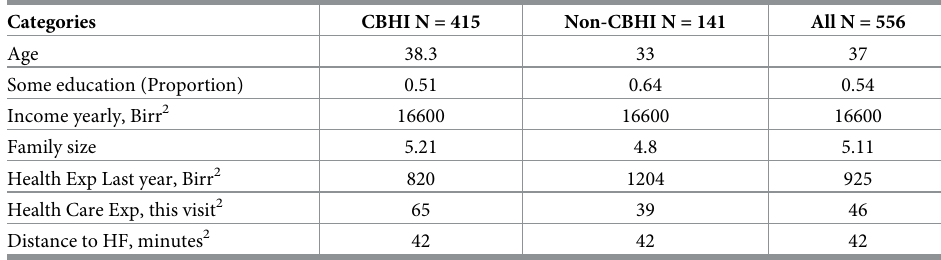
Table 1. Sample characteristics by woreda insurance